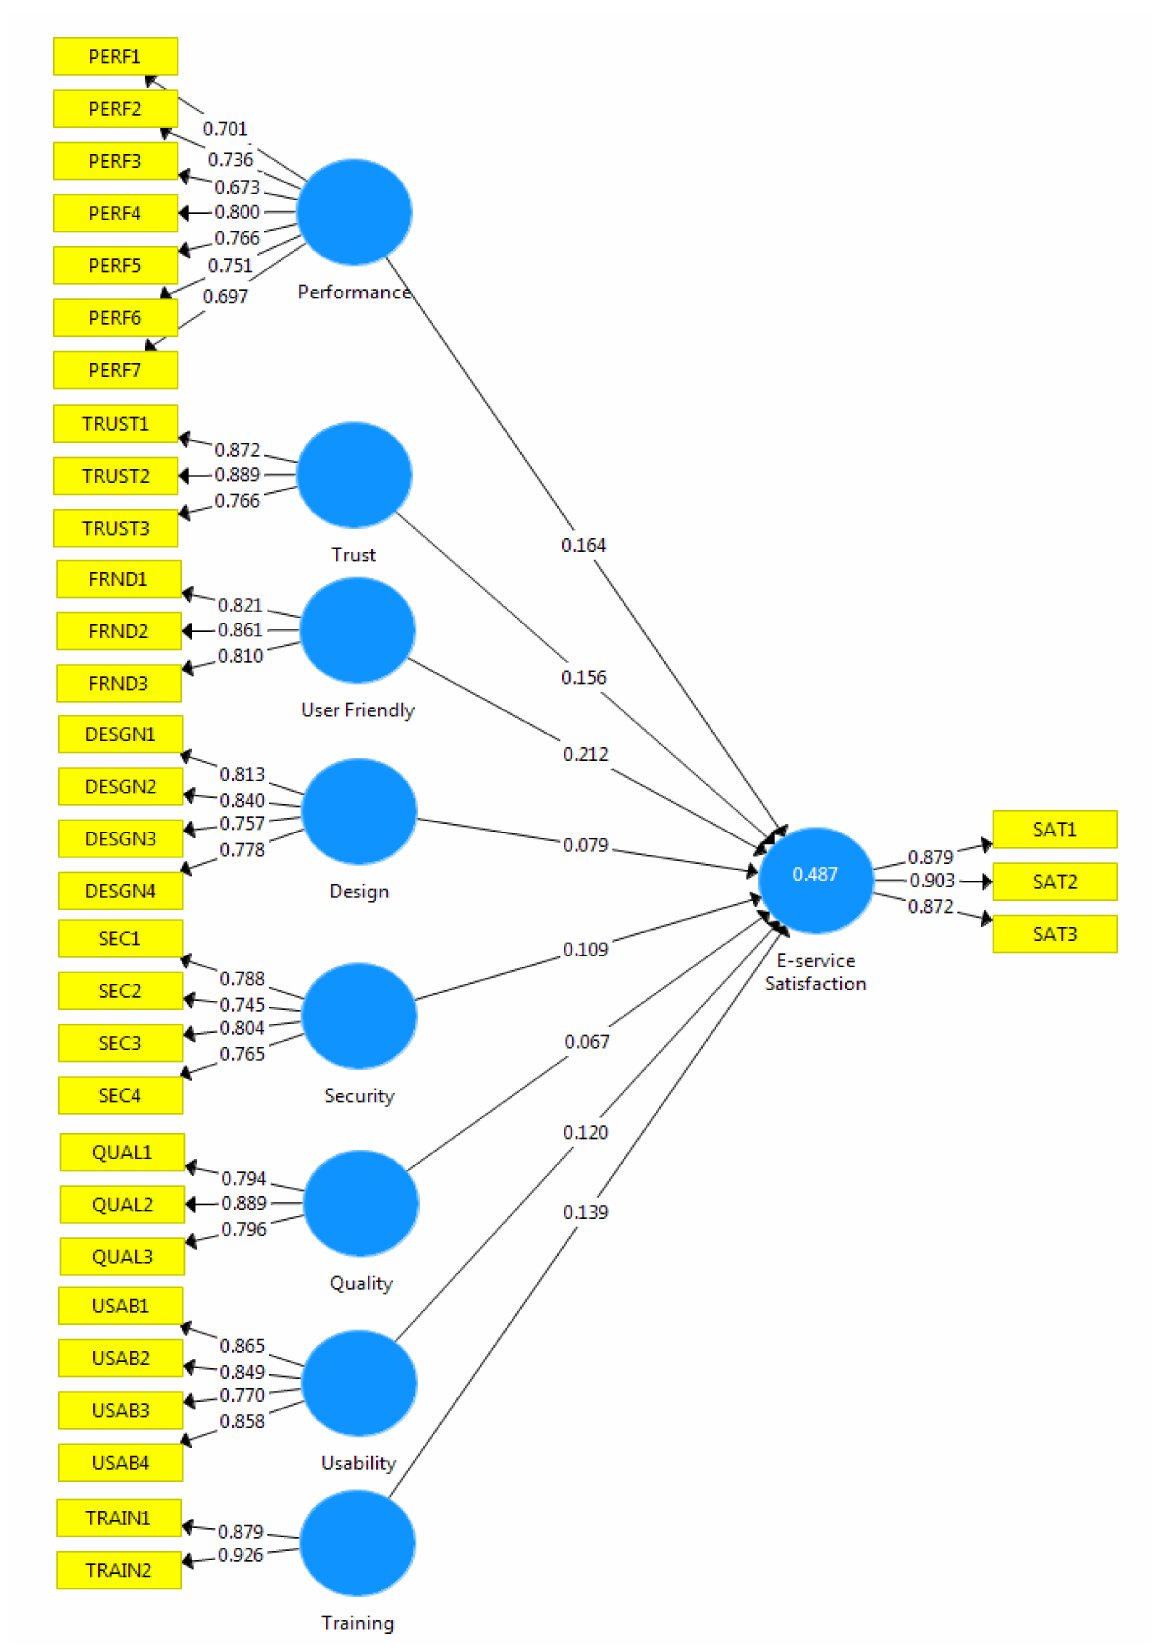
Figure 4. Results of structural equation modeling for the